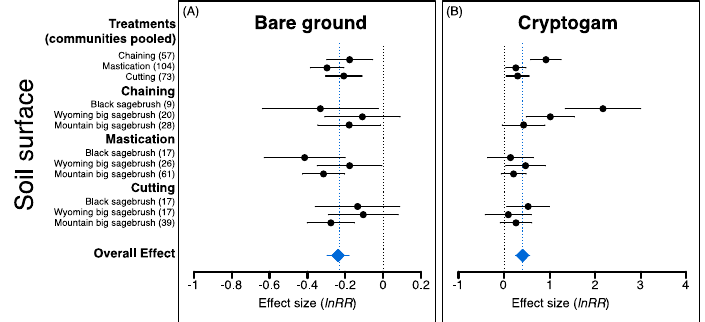
Figure 5. Mean e ff ect sizes and 95% confidence intervals ( lnRR ; pre vs. posttreatment cover) for bare ground ( A ) and cryptogam ( B ) following pinyon–juniper reduction in three sagebrush community types (i.e., black sagebrush ( Artemisia nova ), Wyoming big sagebrush ( A. tridentata ssp. wyomingensis ), and mountain big sagebrush ( A. tridentata ssp. vaseyana )) when treatments are both pooled or separated (solid black circles). Overall e ff ects (blue diamonds) indicate e ff ect sizes for all observations; values in parentheses are the number of observations used to calculate e ff ect sizes. E ff ect sizes are considered significantly di ff erent from one another if confidence intervals do not overlap.